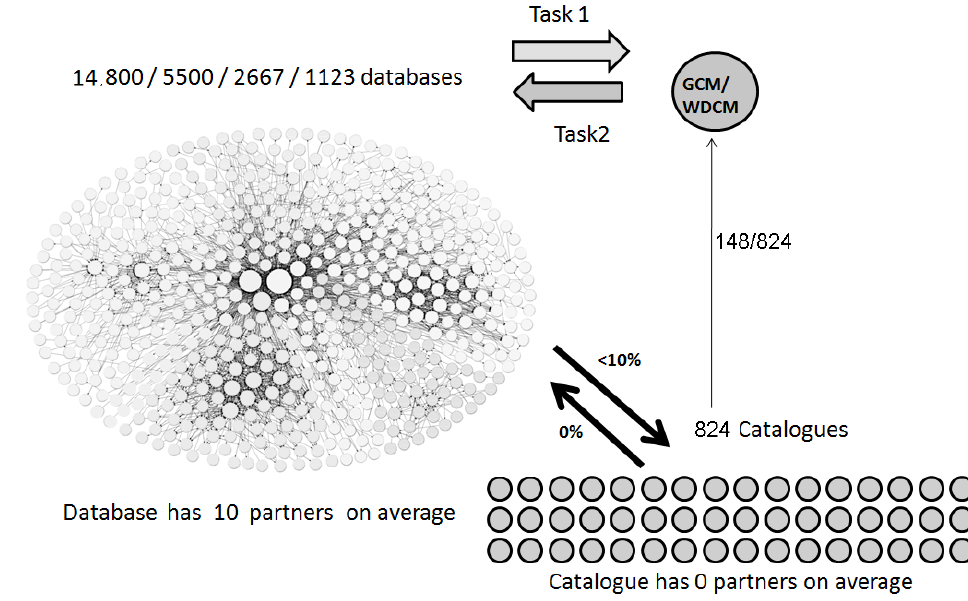
Figure 1. Microbial databases — CC interconnection.